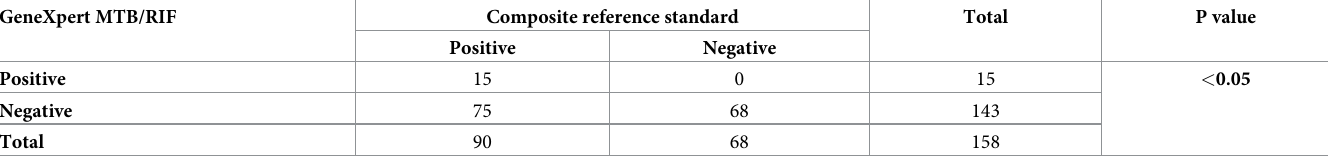
Table 2. Diagnosis of tubercular pleural effusion by GeneXpert MTB/RIF assay and composite reference standard in the study subjects (N = 158).